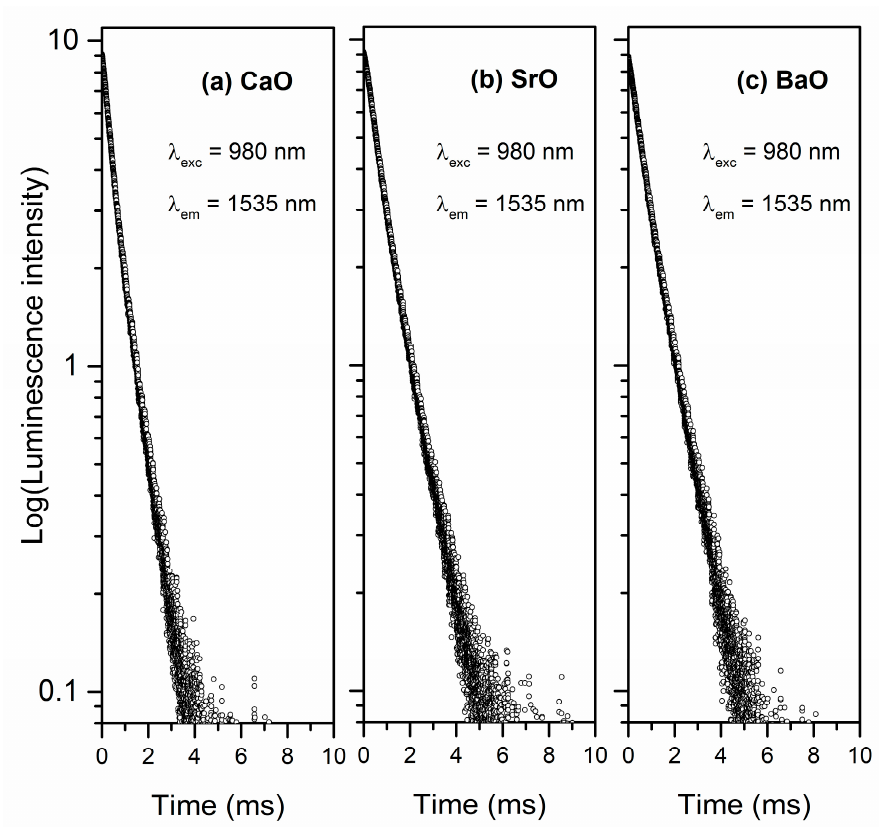
Figure 12. Luminescence decay curves for 4 I 13/2 state of Er 3+ ions in phosphate glasses with oxide glass modifiers MO. Table 4. Comparison of luminescence lifetime for 5 D 0 state (Eu 3+ ) of inorganic glasses. Glass Composition